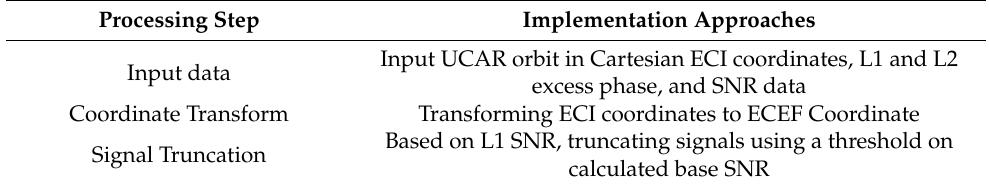
Figure 4. Flow chart depicting the different steps used in the NOAA STAR inversion of geometry and phase data to bending angle and refractivity profiles. Table 1. Overview of the implementation of the STAR processing chain.